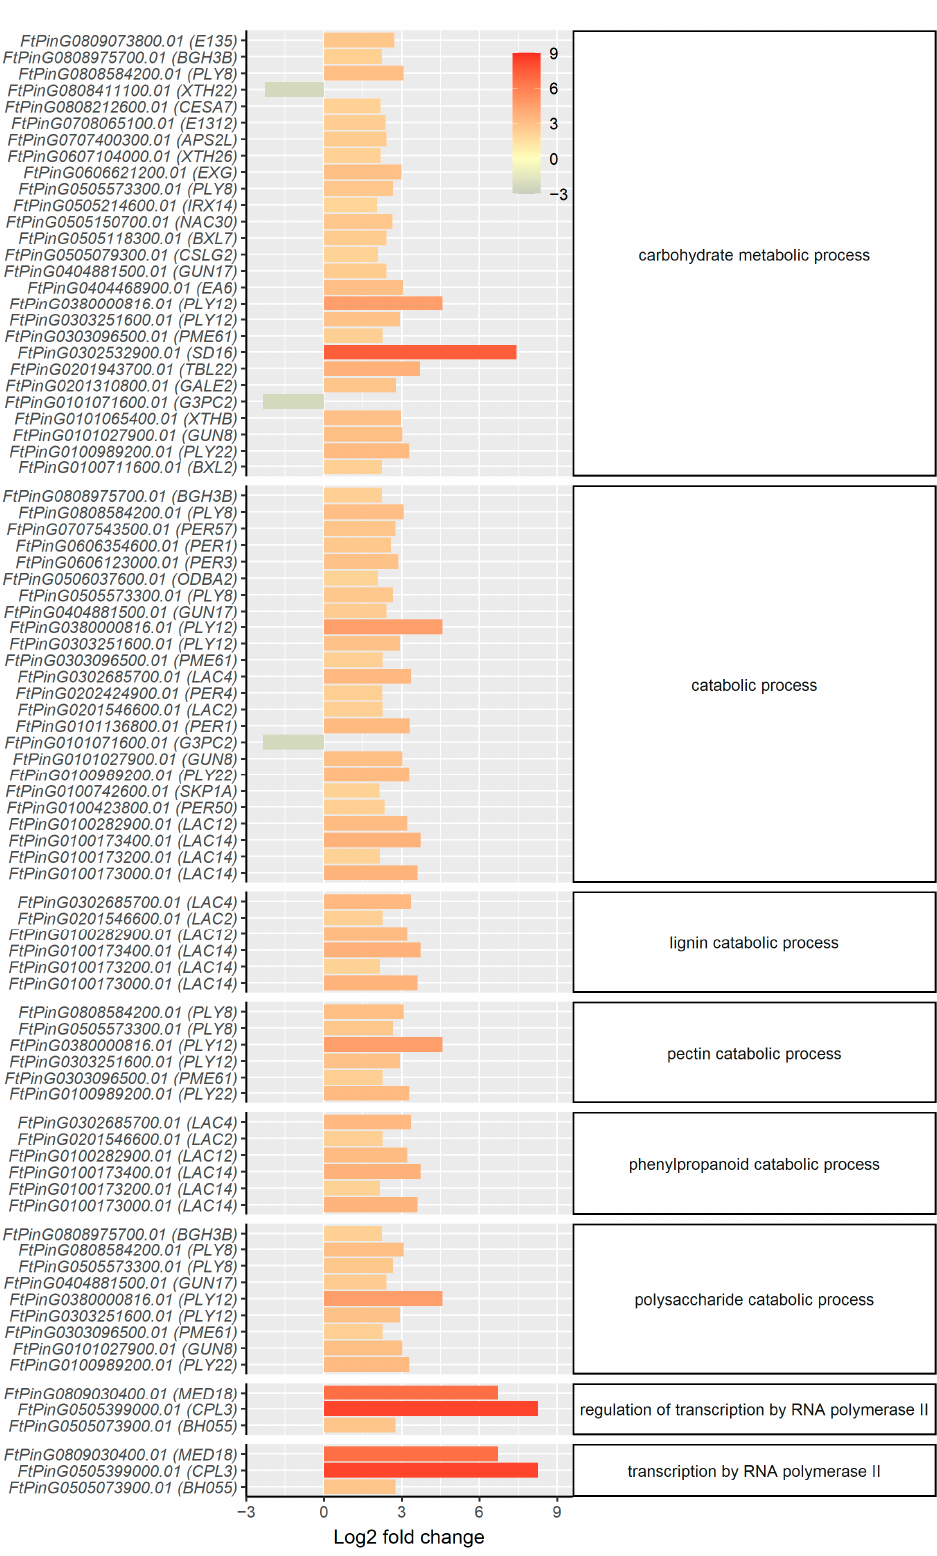
Figure 6. Fold-change of the expression levels of DEGs for the top ten GO terms with lowest p -values in the enrichment analysis. The expression level is measured as TPM of the gene. Only genes with an absolute log 2 fold-change of TPM > 2 are listed in the plot. The labels of the y axis denote the gene name, and the annotation of the gene in Swiss-Prot database is shown in brackets.